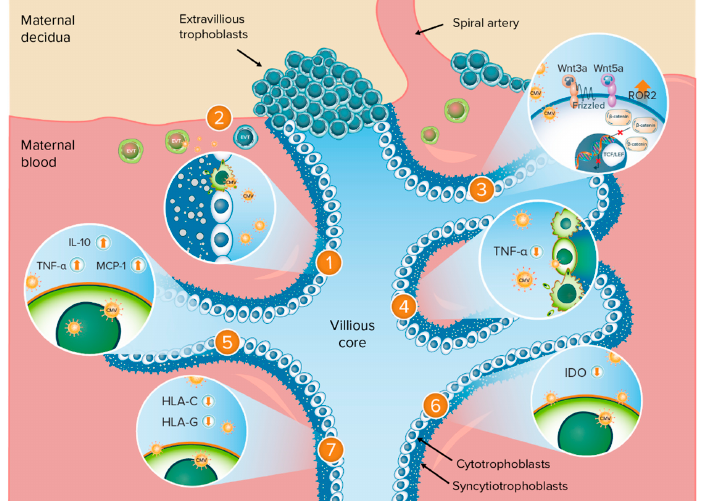
Figure 1. Anatomy of the maternal–fetal interface and potential mechanisms of adverse birth outcomes following CMV infection. Potential mechanisms of adverse birth outcomes following CMV infection: 1. Impairment of TBPC differentiation and function; 2. Impairment of EVT invasiveness; 3. Dysregulation of Wnt signaling pathways in cytotrophoblasts; 4. TNF- α -mediated apoptosis of trophoblasts; 5. CMV-induced cytokine changes in the placenta; 6. Inhibition of IDO activity; 7. Downregulation of trophoblast class I MHC molecules. CMV = cytomegalovirus; EVT = extravillous trophoblasts; HLA = human leukocyte antigen; IDO = indoleamine 2,3-dioxygenase; IL-10 = interleukin-10; MCP = monocyte chemoattractant protein; MHC = major histocompatibility complex; ROR2 = tyrosine kinase-like orphan receptor 2; TBPC = trophoblast progenitor stem cells; TCF/LEF = T-cell-specific factor/lymphoid enhancer-binding factor; TNF = tumor necrosis factor; Wnt = Wingless. Orange up-arrow indicates upregulation or increased expression; orange down-arrow indicates downregulation or inhibition.